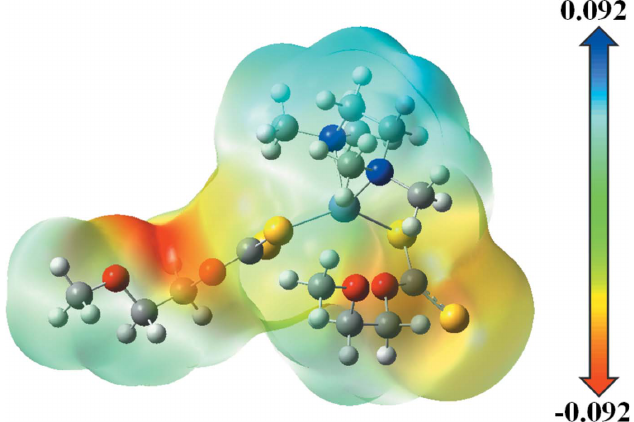
Figure 4 The total electron density three-dimensional surface mapped for the title compound with the electrostatic potential calculated at the B3LYP/6– 311 G(d,p)